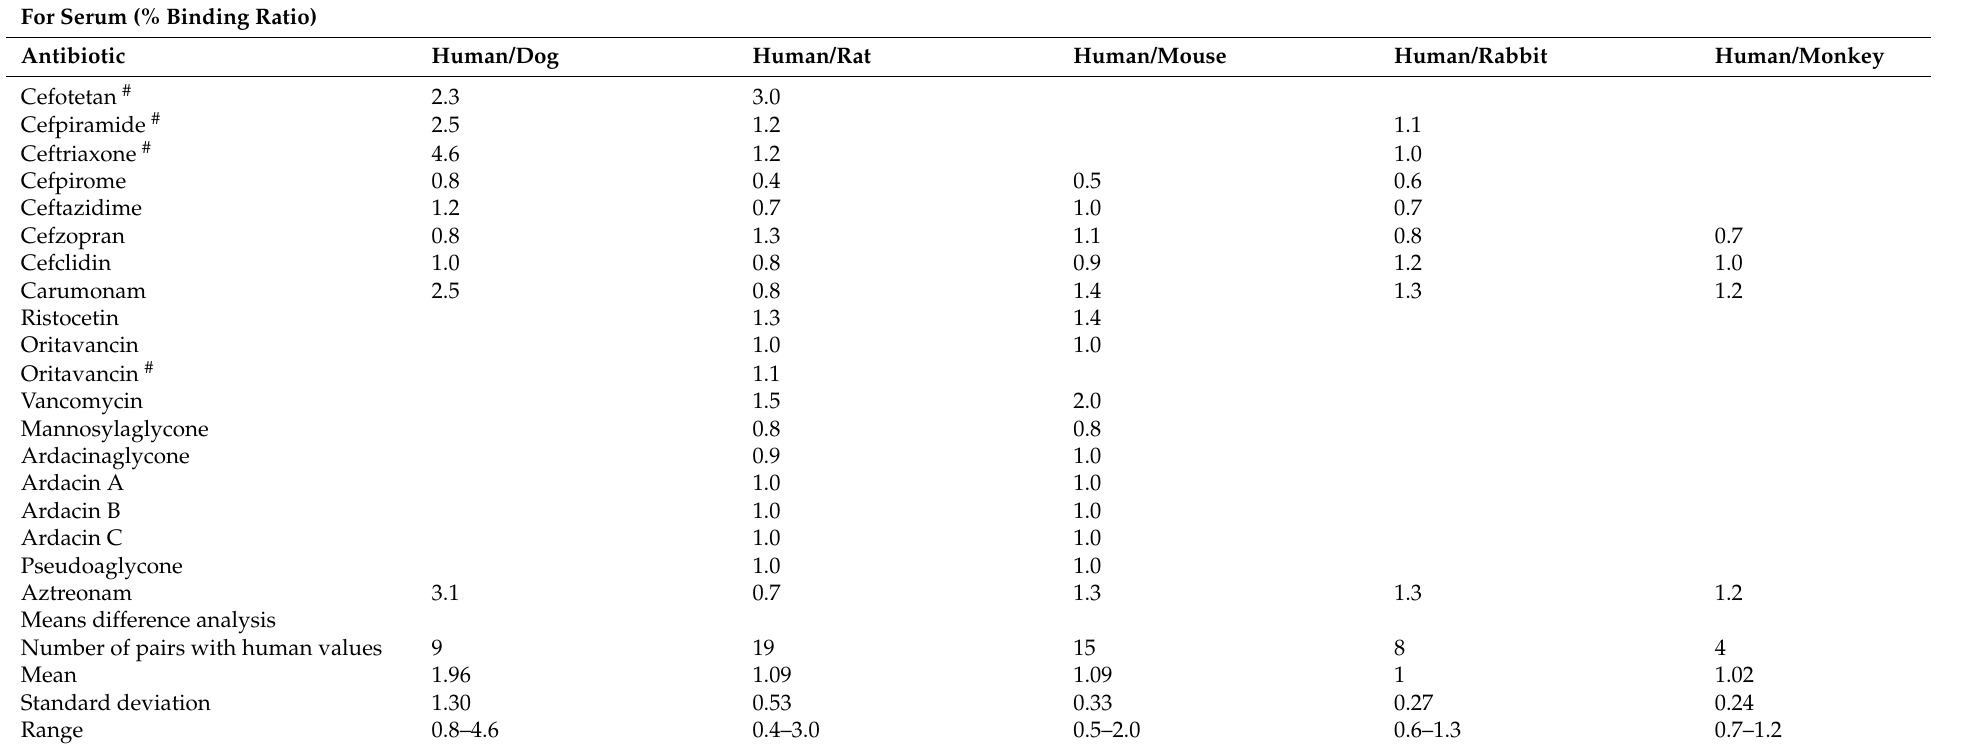
Table 4. Human/animal ratio of protein binding of different antibiotics in serum and plasma. Means difference analysis was performed between antibiotics percentage bound ratio in human and other species. Mean, standard deviation and range of human/animal ratio is